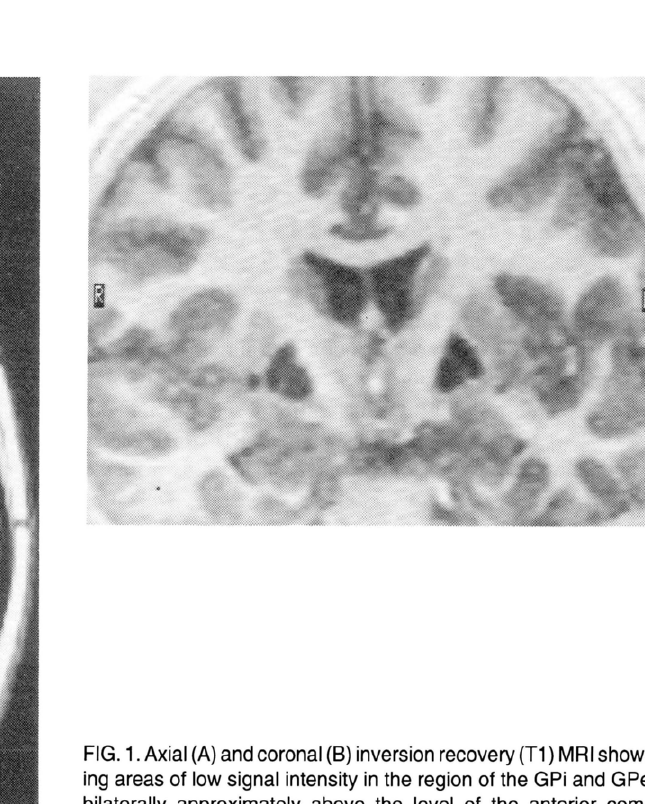
FIG. 1. Axial (A) and coronal (8) inversion recovery (T1) MRI show ing areas of low signal intensity in the region of the GPi and GPe bilaterally approximately above the level of the anterior com missure (8), sparing some tissue in the rostral pole of the GP (A). Areas of abnormal signal are also visible in the outer rim of the ventral and posterior putamen